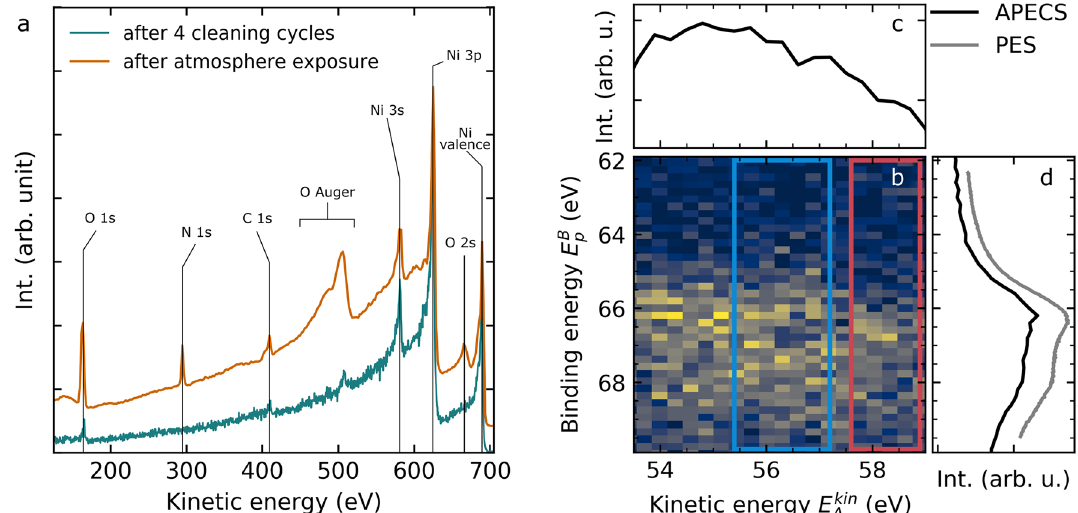
Figure 2. ( a ) PES overview spectra of Ni(111) obtained at 700 eV photon energy. In cyan a PES survey of Ni(111) after multiple cleaning cycles is shown. In orange a PES survey of the air exposed Ni(111) is shown. The spectra were normalized to the Ni 3 p intensity. An offset was introduced for better visibility. Peaks are assigned to the corresponding elements. ( b ) Ni MVV Auger electron ( E Au ) Ni 3 p photoelectron ( E pe ) coincidence map (17,889 true counts) corrected for accidental counts. The marked regions are used for later analysis shown in Fig. 3. ( c ) Integration of the full map along the photoelectrons ( along the y-axis, 62–70 eV binding energy) results in MVV Auger spectrum. ( d ) Integration of the full map along the Auger electron axis (along the x-axis, 53–60 eV kinetic energy) results in 3 p photoelectron spectrum. In gray a non-coincidence ESCA spectrum is shown. The figure was created using the python matplotlib package 53 and inkscape 54